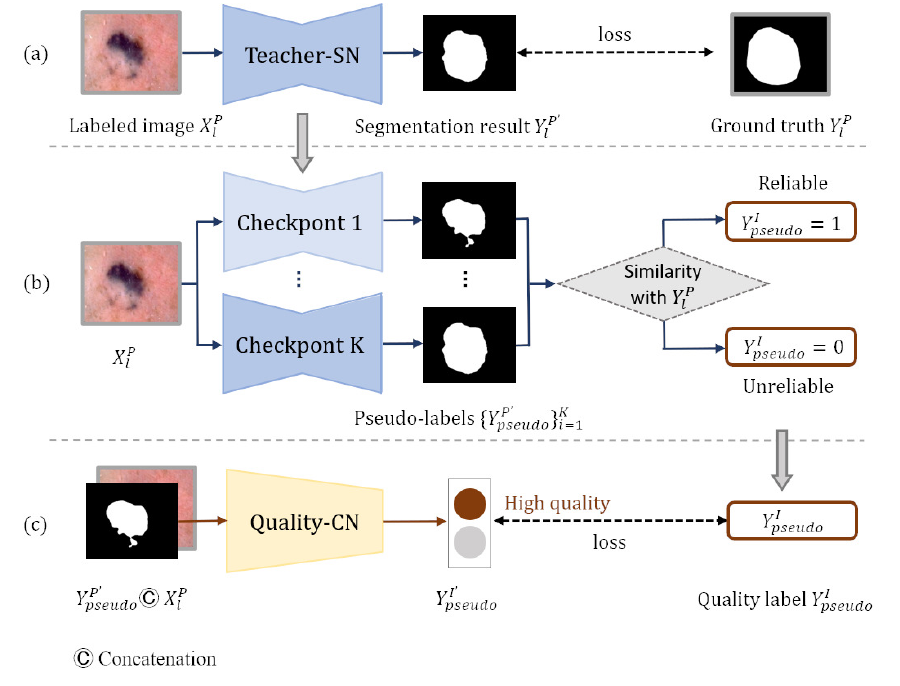
Figure 3. Generating reliable pseudo-labels: ( a ) generating pseudo-labels, ( b ) generating pseudo-label quality level training set, and ( c ) screening reliable